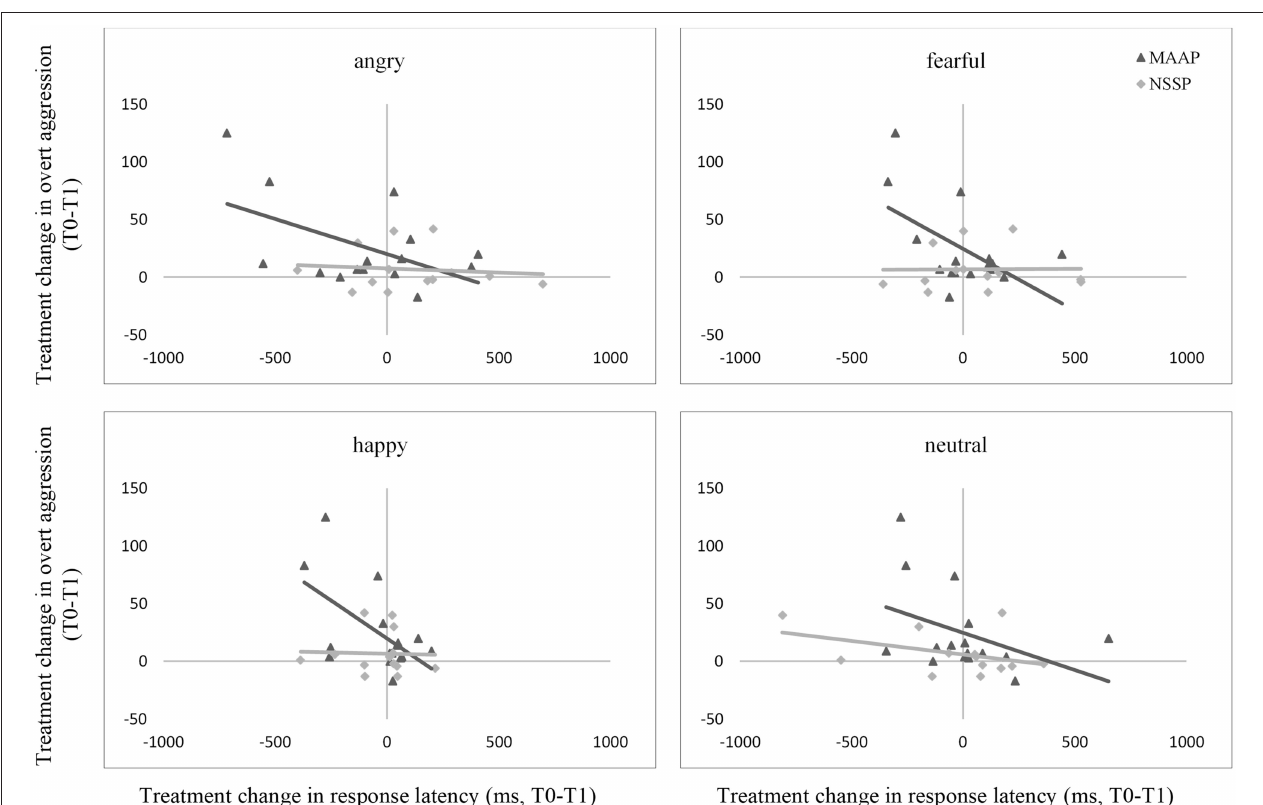
FIGURE 2 | Associations between treatment change through MAAP and NSSP in overt aggression and response latency when classifying angry, fearful, happy, and neutral facial expressions. The displayed graphs represent the correlations between treatment change in overt aggression and response latency through MAAP and NSSP, respectively. T0, pre-treatment measurements; T1, post-treatment measurements; OAS-M, Overt Aggression Scale Modified, Items 1-3. Please note that data from HC is not displayed for better clarity of graphs since treatment change in overt aggression in this group was